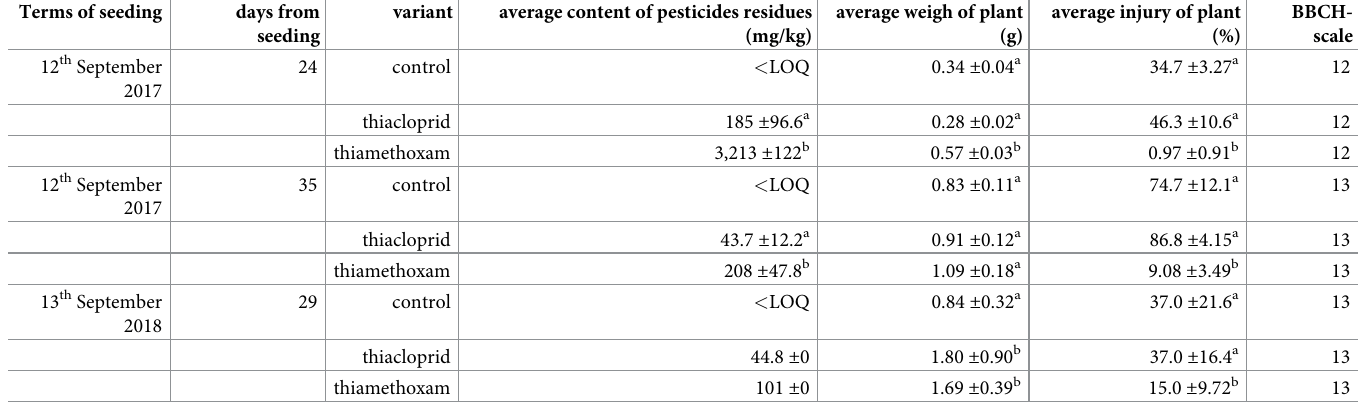
Table 2. Content of pesticide residues in oilseed rape plants (values ± standard deviation), average weight of plants before analysis and average injury to plants caused by CSFB. Values with different letters within a column in each experiment are significantly different. LOQ–limit of quantification of the analytical method. Terms of seeding days from variant average content of pesticides residues average weigh of plant average injury of plant BBCH- seeding (mg/kg) (g) (%)